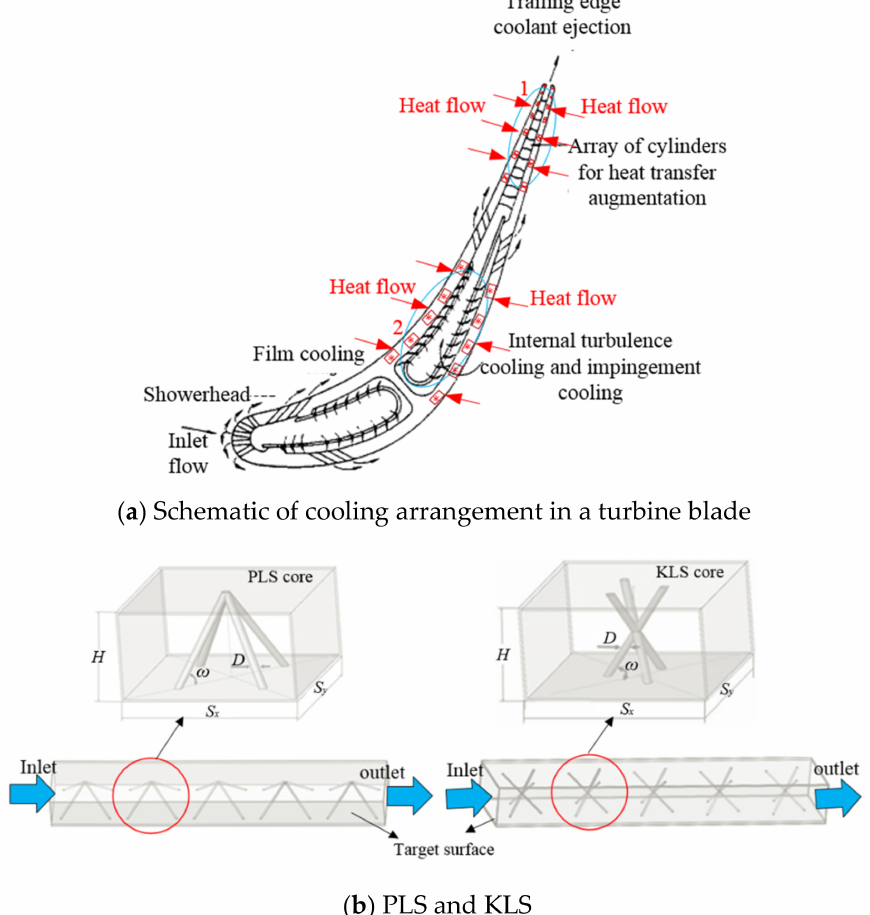
Figure 1. Cooling structures of turbine blade and LS cooling channels. There were five geometric parameters about the LS core, which were member diameter ( D ), member inclination angle ( ω ), length ( S y ), width ( S x ) and height ( H ) of a single LS core. The key variables of the optimization model were H , D and ω , shown in Table 1. The aspect ratio meant a ratio of width to height of the LS core which considered different sizes of LS cooling channels used in the thin-wall